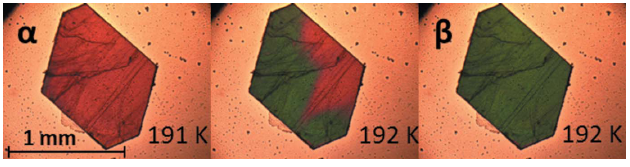
Figure 10 Snapshots of the dl -Nva (cid:2) ! (cid:3) phase transition during heating, showing that the propagation fronts are parallel to the crystal